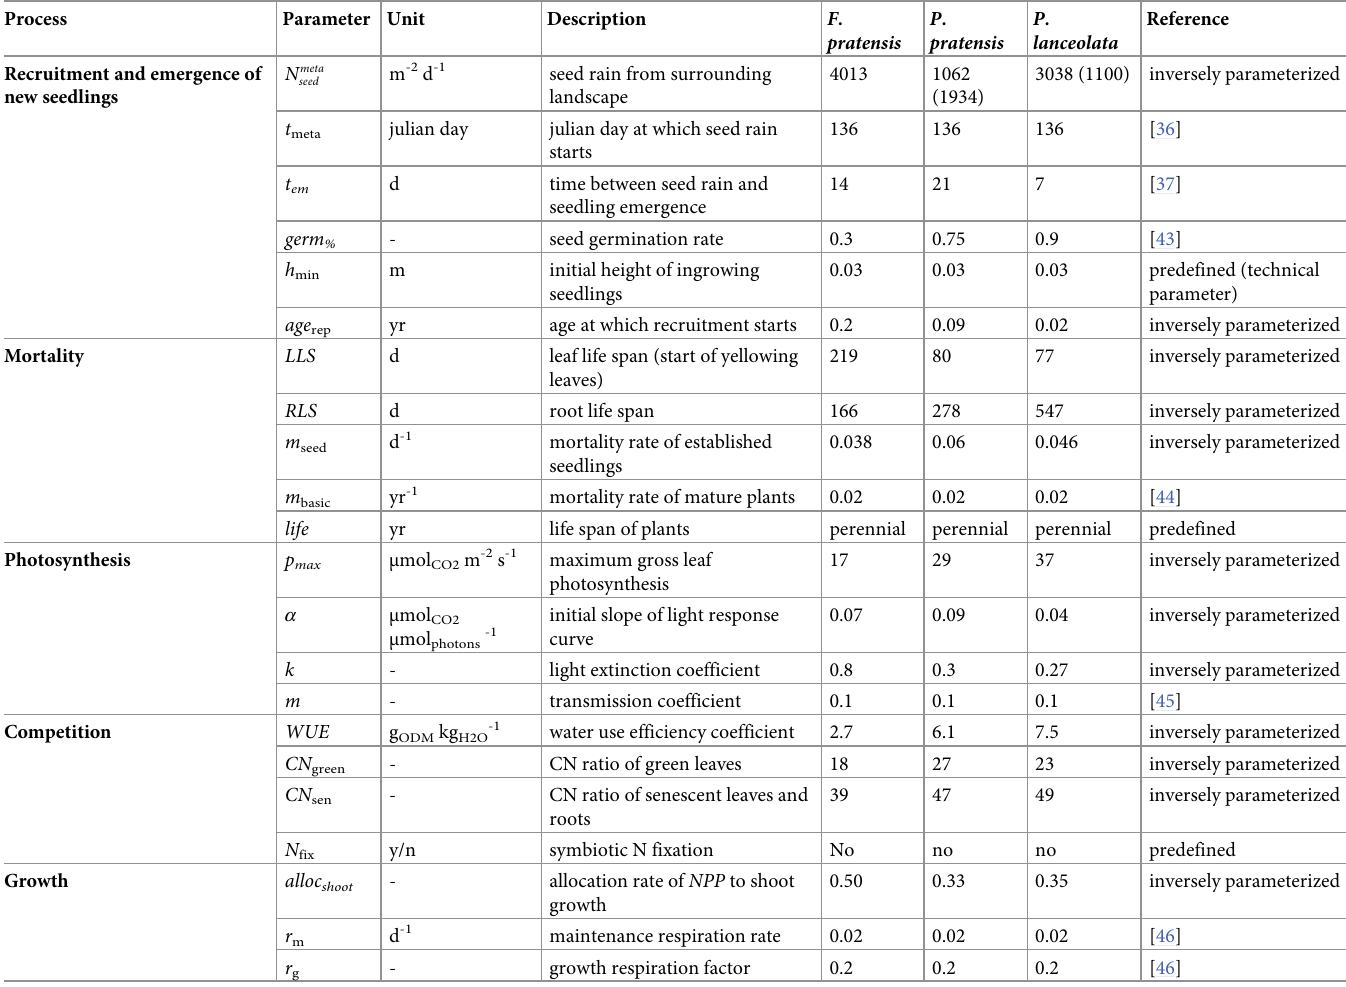
Table 2. Model process parameters for the three species.